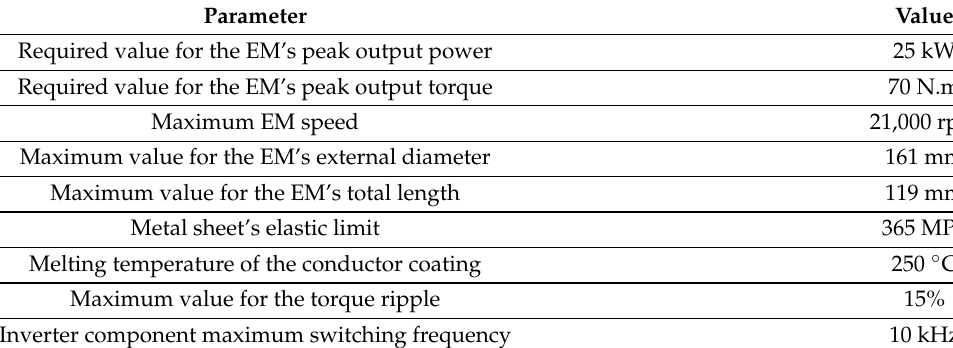
Table 4. Required values for the definition of EM design constraints. Parameter Value Required value for the EM’s peak output power 25